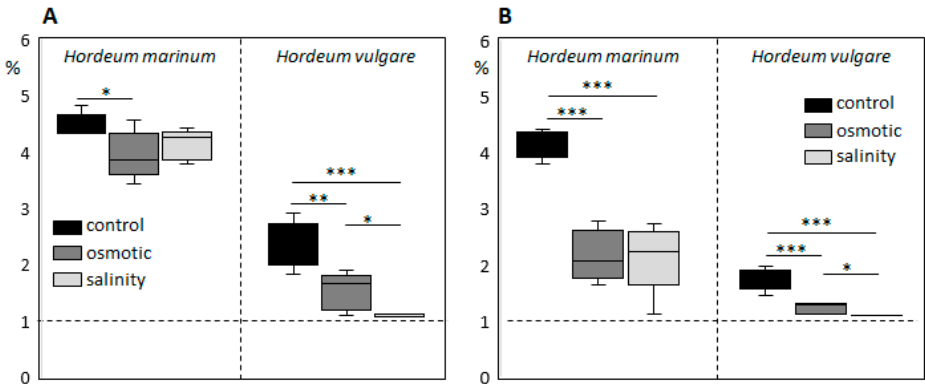
Figure 3. 13 C uptake and distribution in shoots ( A ) and roots ( B ) of Hordeum marinum and H. vulgare plants under control conditions as well as under osmotic and salinity stresses. Dashed lines indicate natural 13 C abundance. Data are mean ± SD; n = 5, t significant at: *, p < 0.05; **, p < 0.01; ***, p < 0.001.